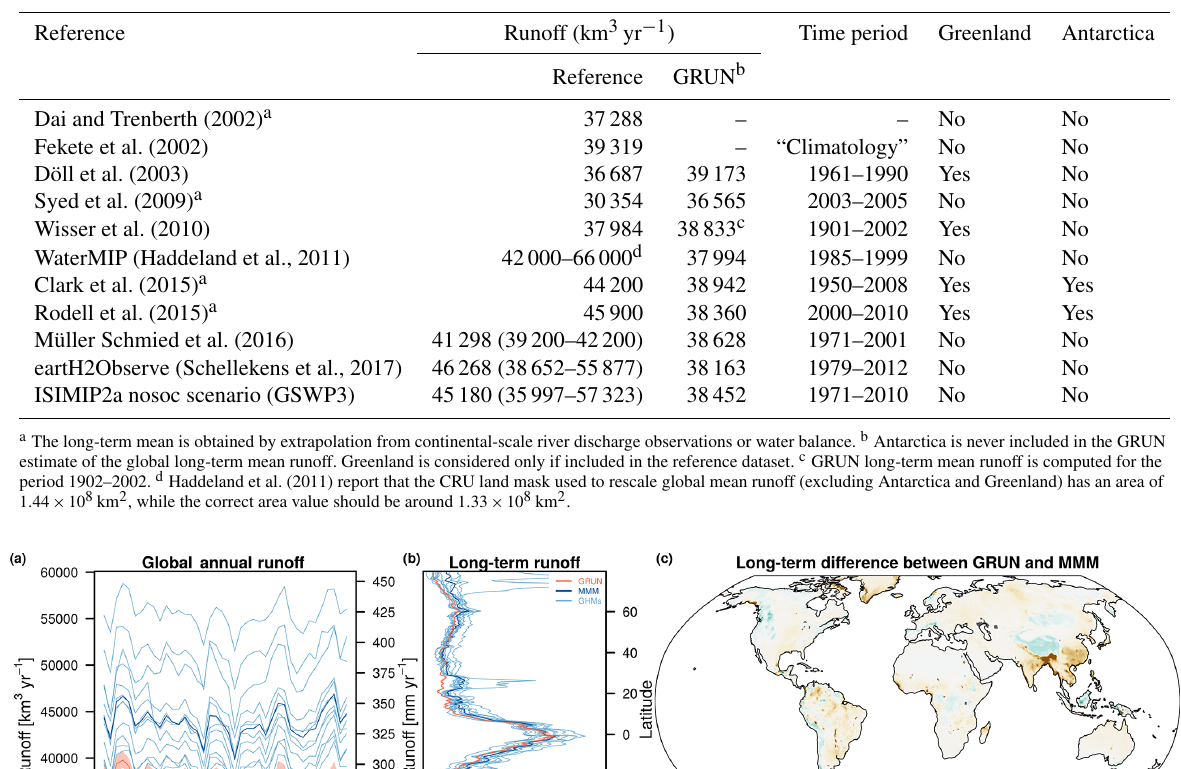
past periods of near-natural streamflow. This may be one